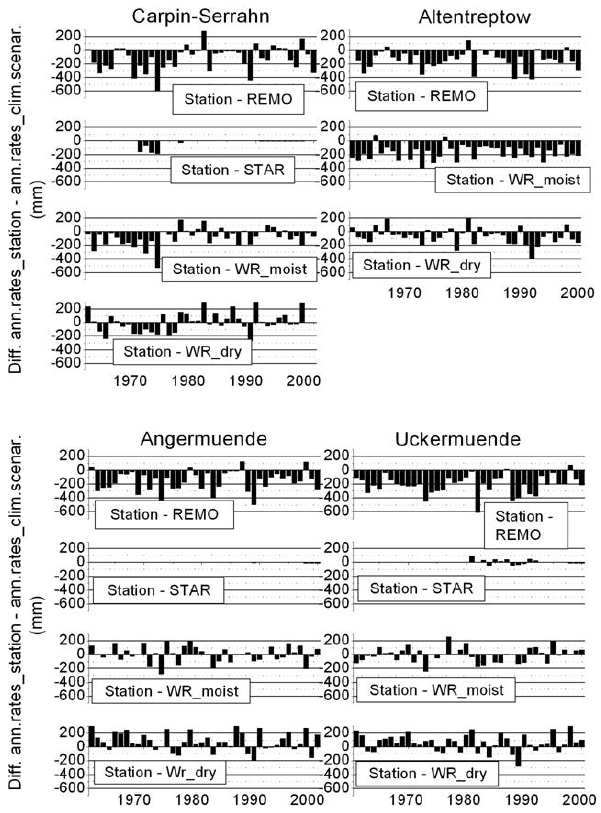
Fig. 5. Differences between annual rates of precipitation mea- sured at the weather stations Carpin-Serrahn, Altentreptow, Anger- muende and Uckermuende and corresponding rates obained from the climate change scenarions REMO (=Station – REMO), STAR (=Station – STAR), WettReg dry (=Station – WR dry) and Wet- tReg middle (=Station – WR m) for the control period 1961–2000.